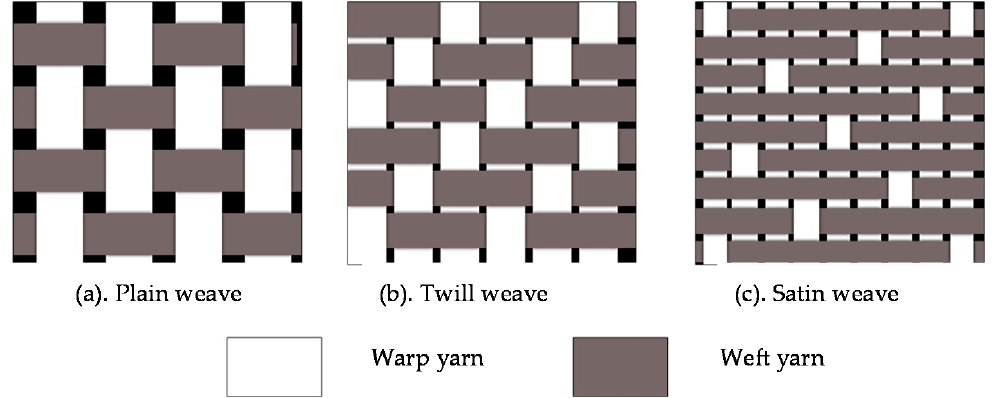
Figure 6. Woven fabric terminology.